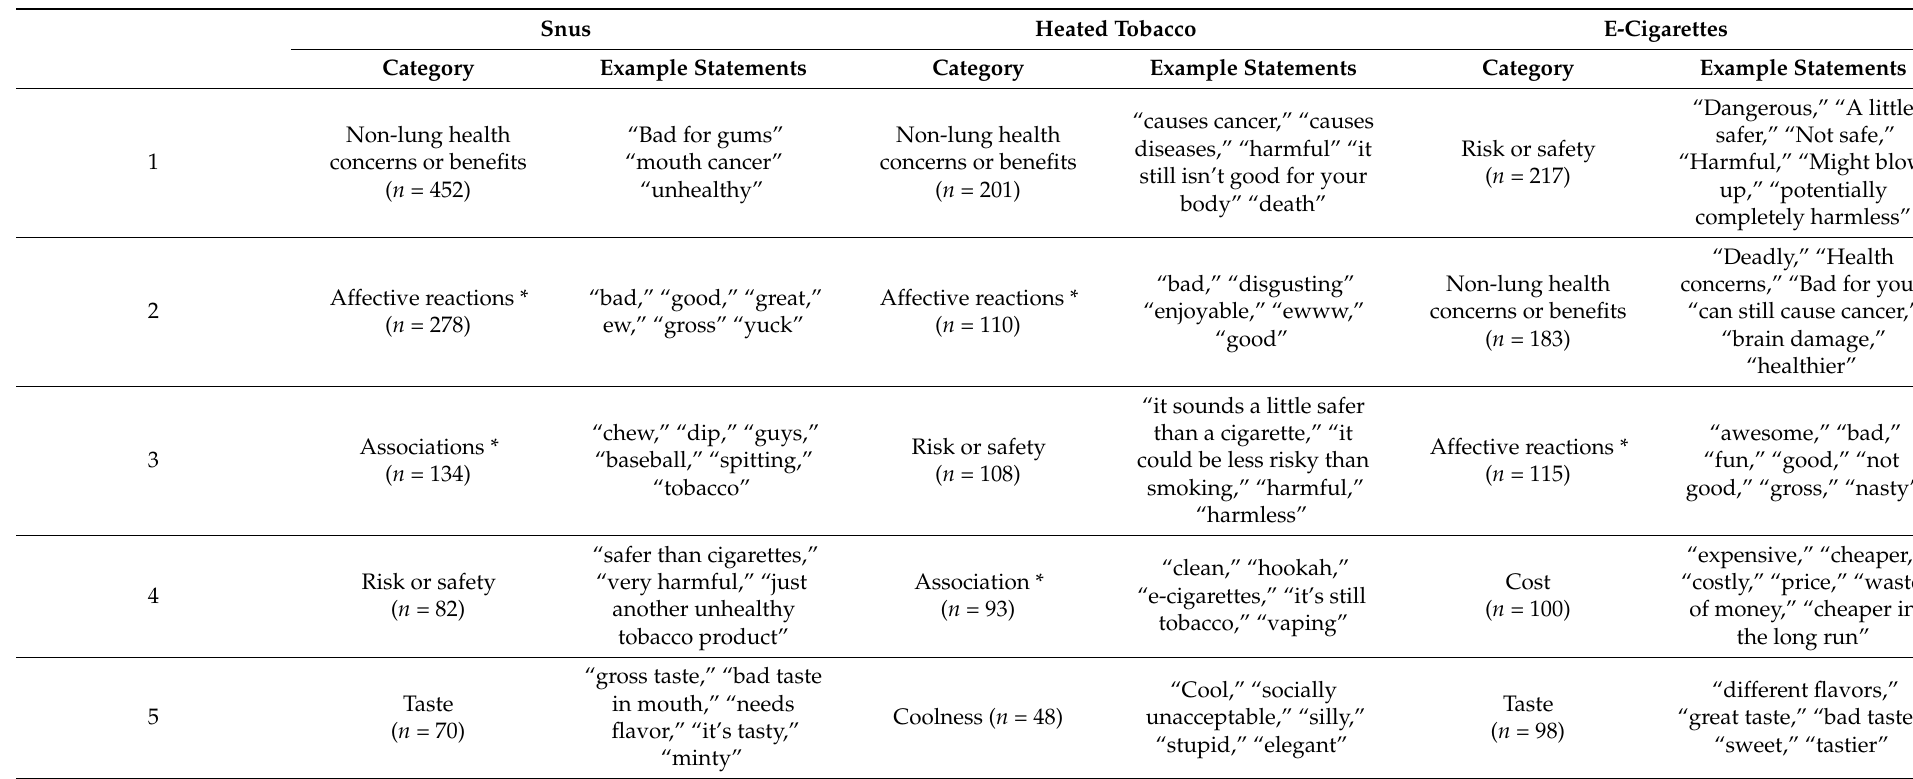
Table 5. The top five most common open-ended response categories and example statements for three types of potentially modified risk tobacco